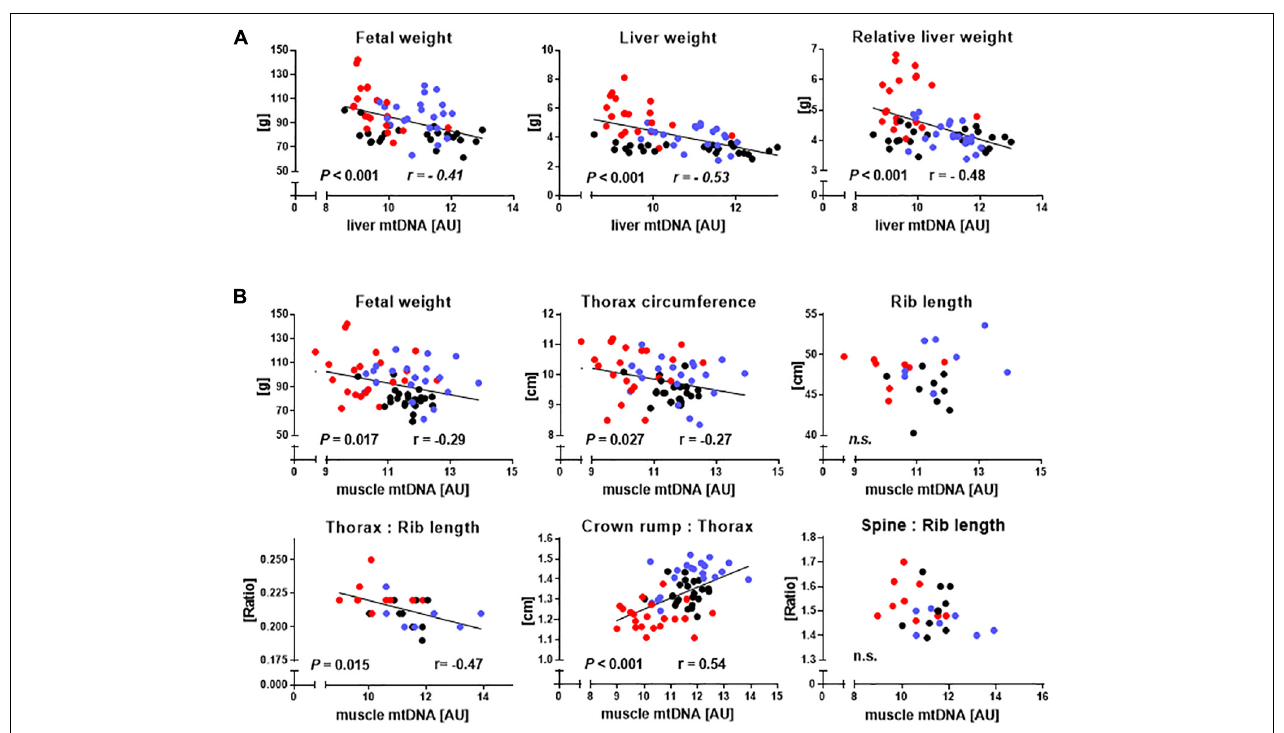
FIGURE 4 | Relationships between hallmarks of somatic cell nuclear transfer (SCNT) specific disproportionate fetal overgrowth and mtDNA amount in liver and skeletal muscle. (A) Regressions of fetal weight and absolute and relative liver weight on liver mtDNA amount of somatic cell nuclear transfer (SCNT, red), in vitro fertilization (IVF, blue), and artificial insemination (AI, black) fetuses. (B) Regression of phenotypic parameters describing increased fetal muscle mass on muscle mtDNA amount. Rib length is the combined length of both sixth ribs, thorax:rib length is the ratio of thorax circumference to combined length of both sixth ribs, crown rump:thorax is crown-rump length to thorax circumference ratio, and spine:rib length is the ratio of the length of the spinal column to the combined length of both sixth ribs. Significant P -values and Pearson correlation coefficients (r) are shown. MtDNA amount is expressed in arbitrary units